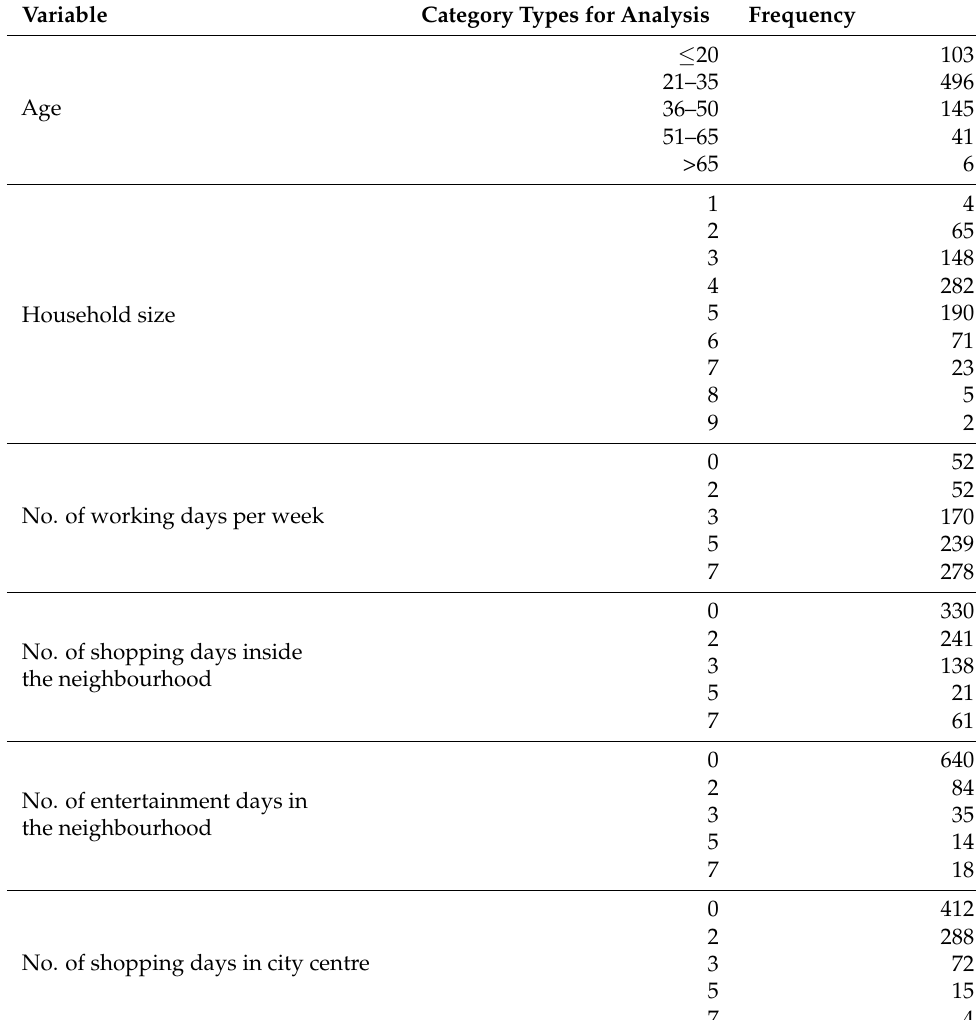
Table 1. The frequencies and categories of the independent variables in the sample.